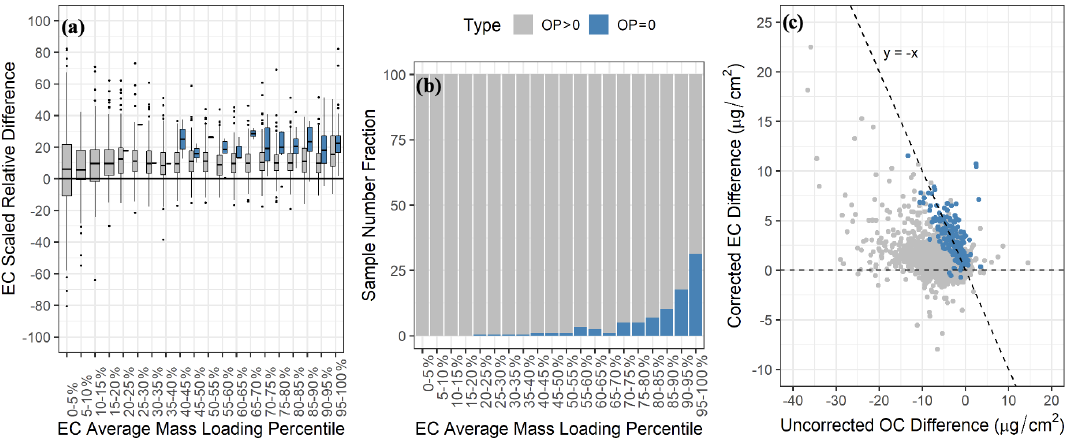
Figure 5. (a) Distribution of scaled relative difference in EC between Sunset and DRI model 2015 for samples with (i.e., OP > 0) and without (i.e., OP = 0) reflectance charring correction on both analyzers, (b) number fraction of samples that had no reflectance charring correction (i.e., OP = 0) in each EC mass loading bin, and (c) scatter plot of arithmetic difference in EC vs. arithmetic difference in OC 1 + 2 + 3 + 4 between Sunset and DRI model